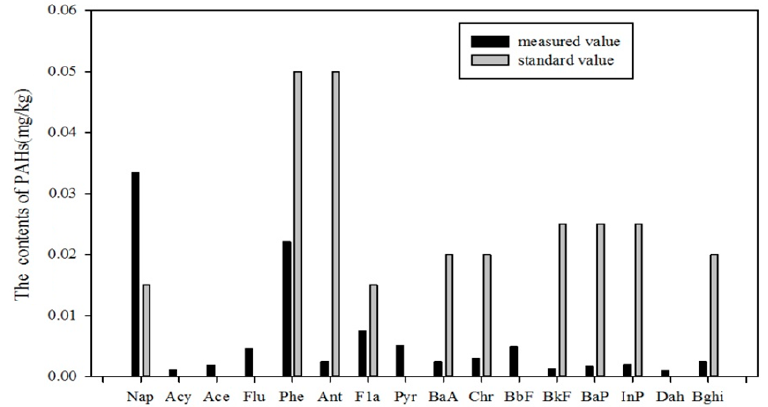
Figure 9. Comparison of the determinations with standard values for PAHs of soils in the Momoge Wetland.